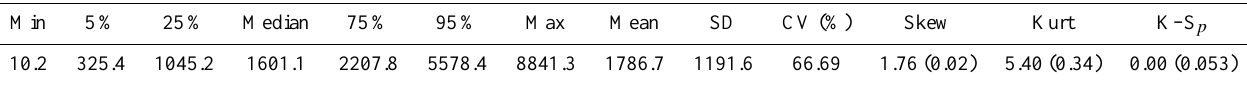
Table 1. Descriptive statistics ∗ of forest litter carbon density (kg ha − 1 ) .